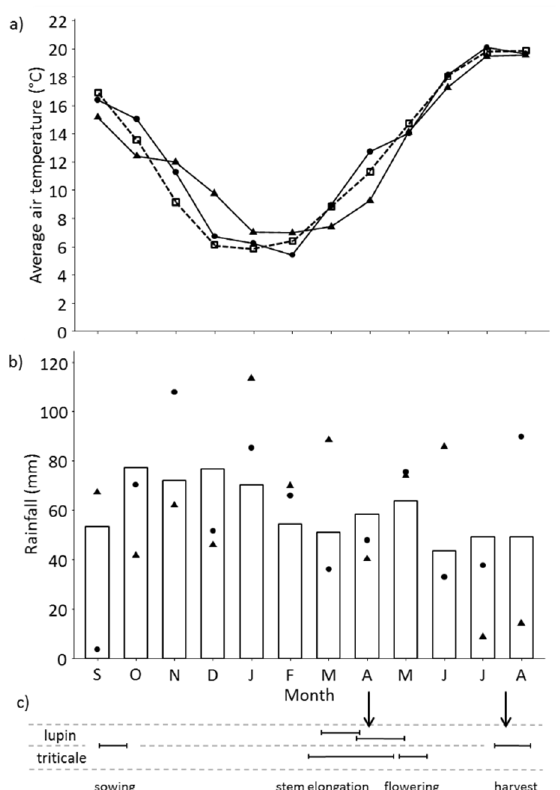
Figure 1. ( a ) Monthly average air temperature, ( b ) monthly rainfall, averaged over the study sites in 2015 (dots) and 2016 (triangles) as well as the 20-year average (temperature: open squares, rainfall: bars) and ( c ) average timing of key events of the crop cycle. Arrows represent the two harvests: at lupin main stem flowering and at lupin maturity.